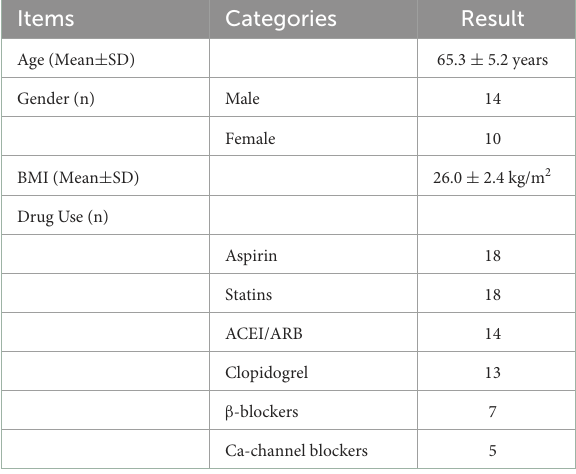
TABLE 1 The general characteristics of the participations.